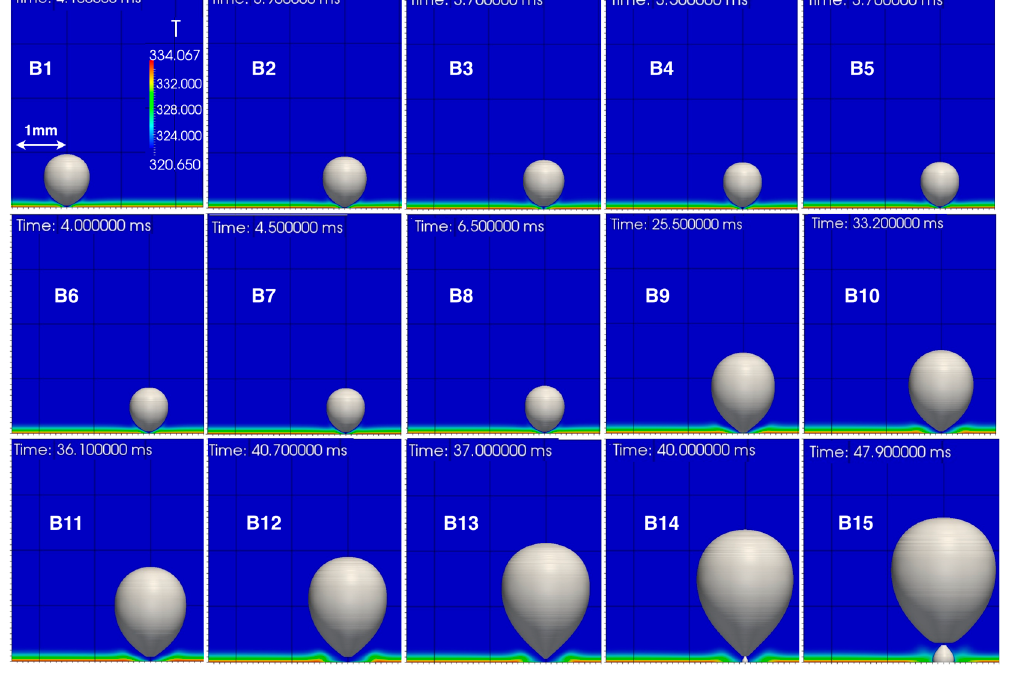
Figure 15. Spatial evolution of generated bubble at the time of detachment for each case R22 of the Series B parametric numerical simulations.